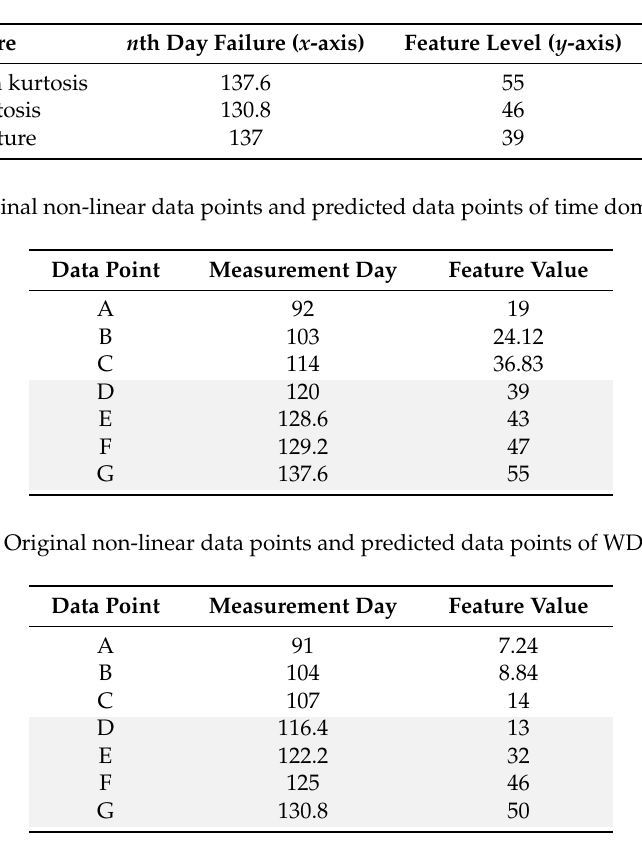
Table 8. The prediction of failure day.